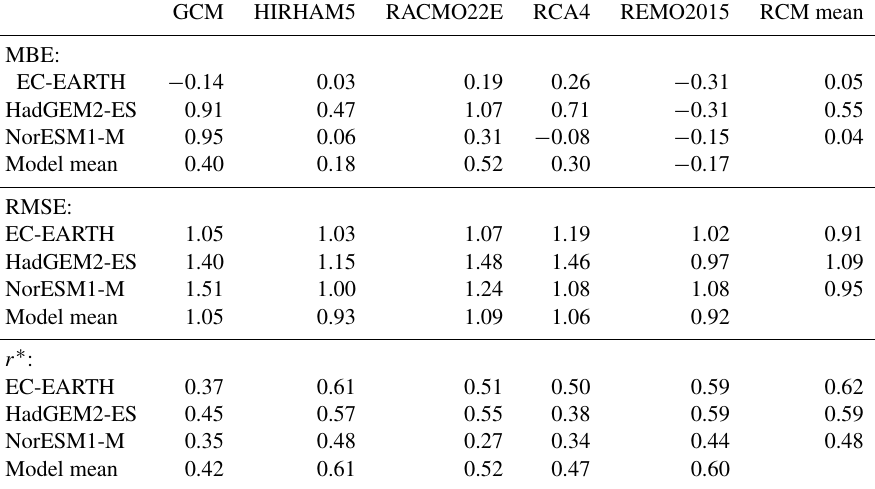
Table 5. Similar to Table 4 but for the recent past climate (1981–2020, with the reference period of HWMId as 1981–2010).